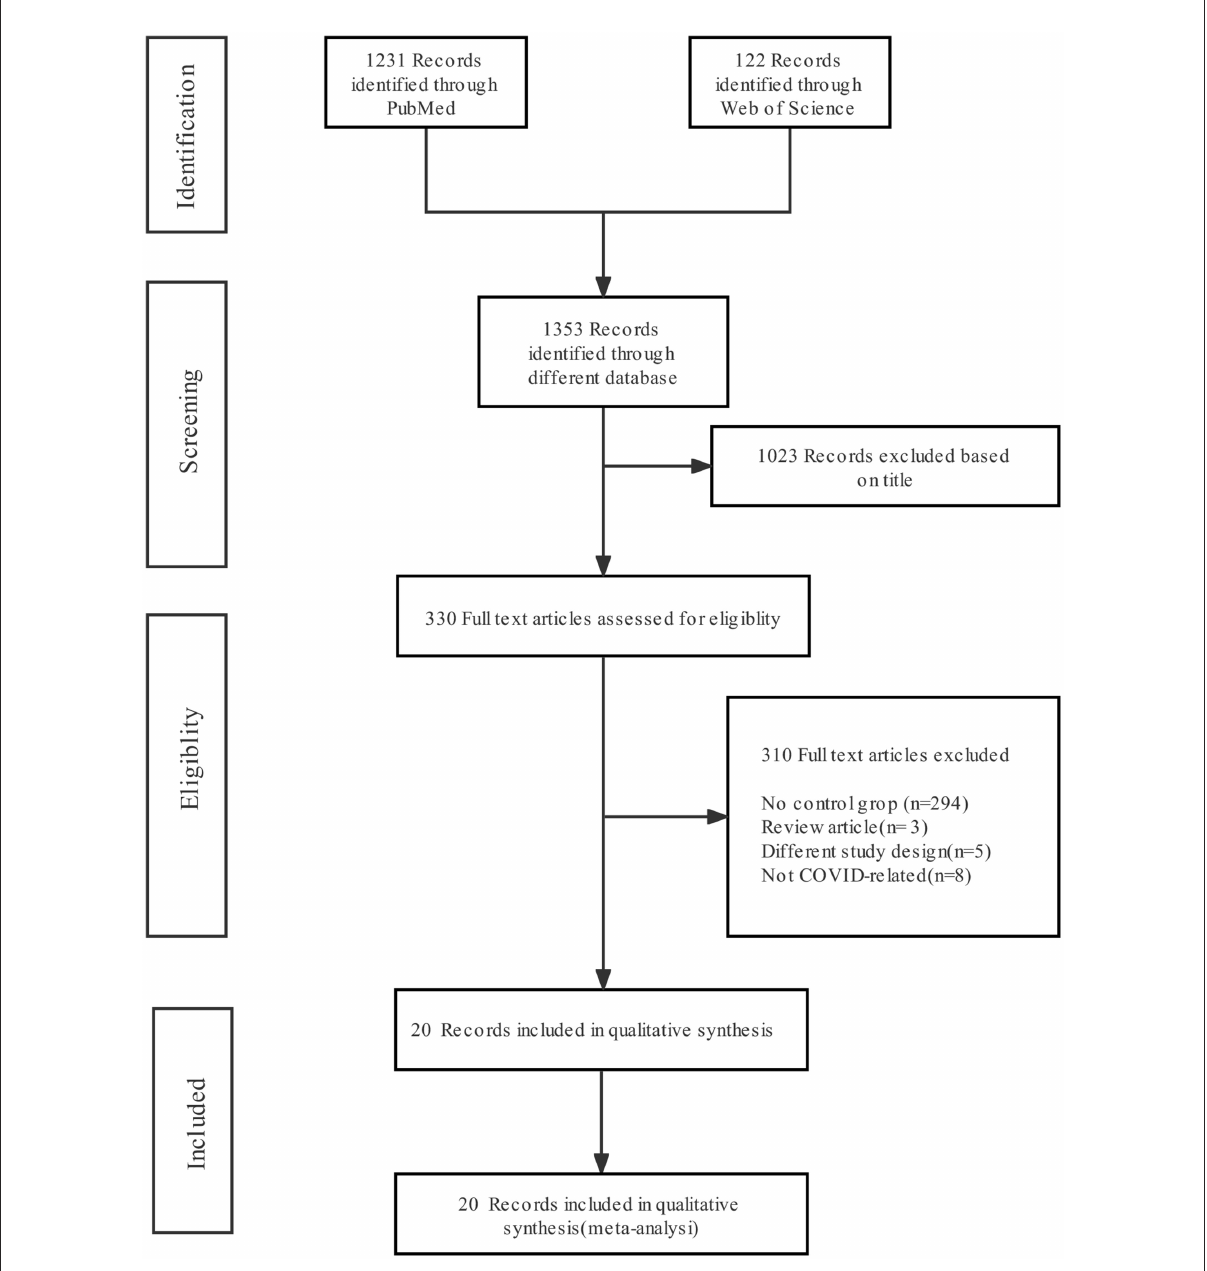
FIGURE1 Preferred Reporting Items for Systematic Reviews and Meta-Analysis (PRISMA) flow diagram of the search results and article exclusion details.